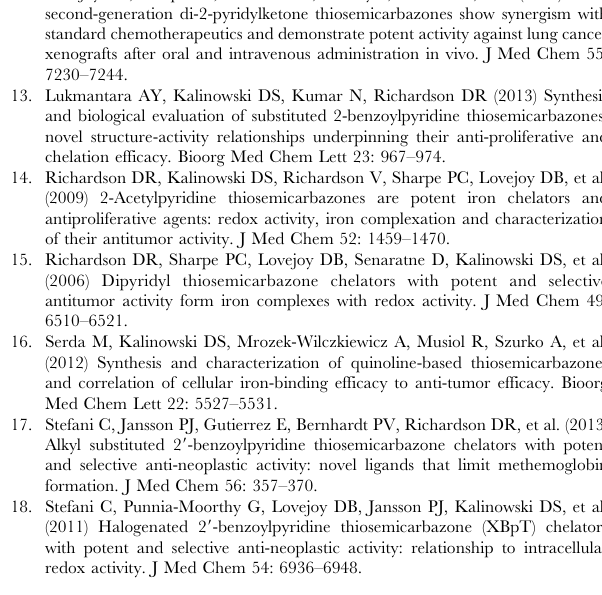
Figure S4 , Color maps of the anti-proliferative activity of series 1–6 in several tumor cell-types and normal human dermal fibroblast (NHDF) cells. Red represents the thiosemicarbazones with the greatest anti-proliferative activity (IC50: , 1 m M), yellow represents the thiosemicarbazones with moderate activity (IC50: 1–6.25 m M) and grey represents those analogs with poor anti- proliferative effects (IC50 . 6.25 m M). Table S1 , Crystal data of a and 1d . Table S2 , HPLC purity data for all chelators of series 1– 6